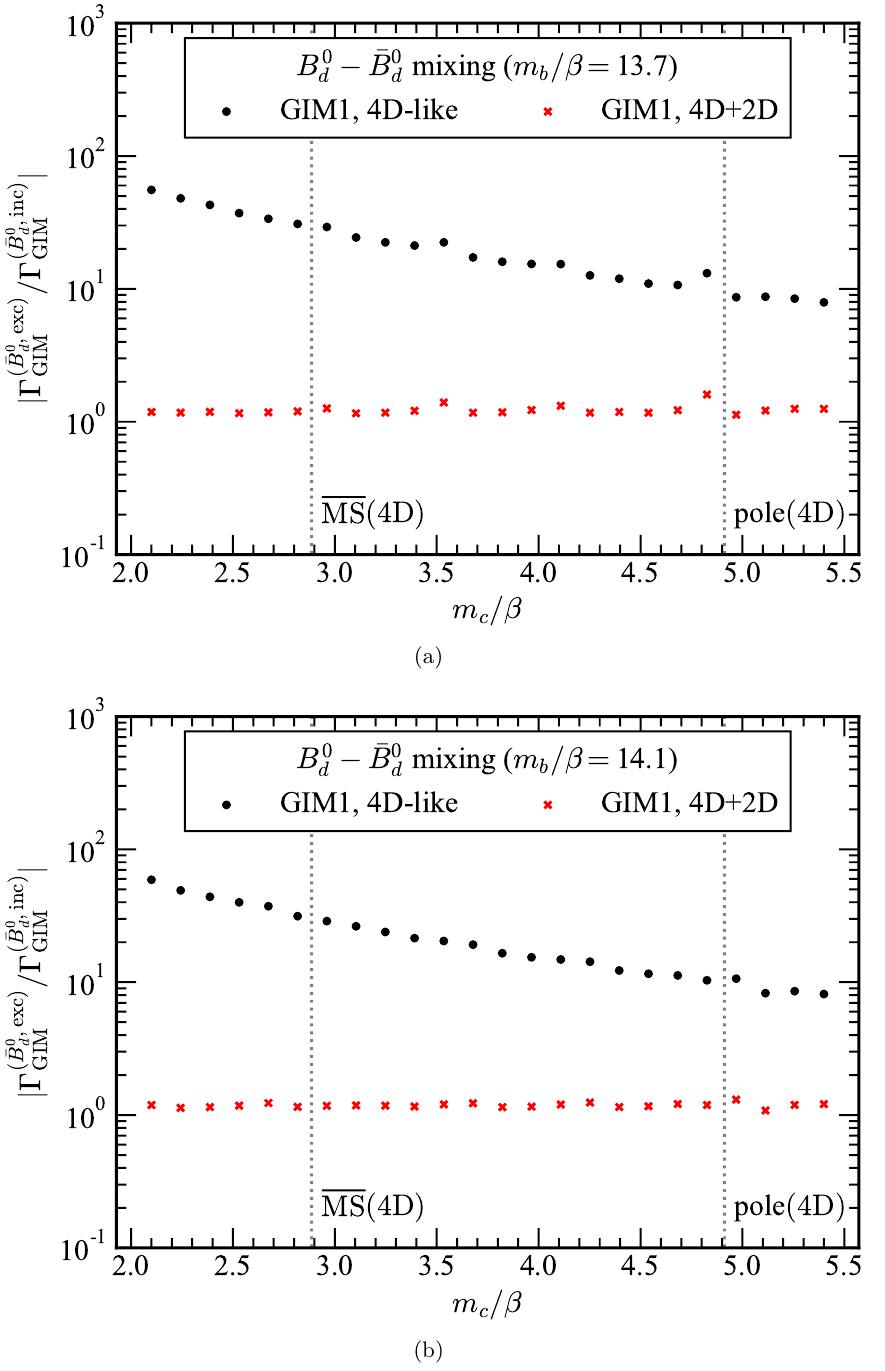
¯ mixing: (a) m − B 0 d d